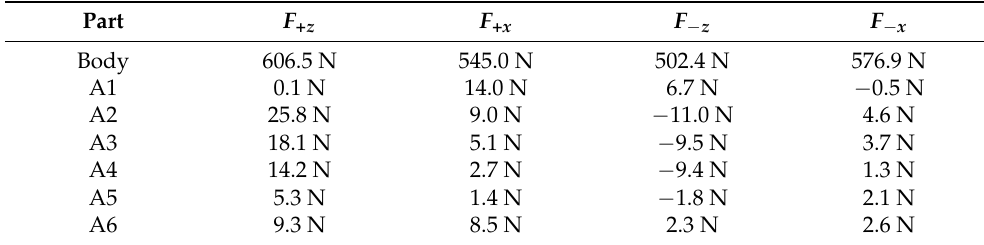
Table 2. Steady Hydrodynamic Force of Each UVMS